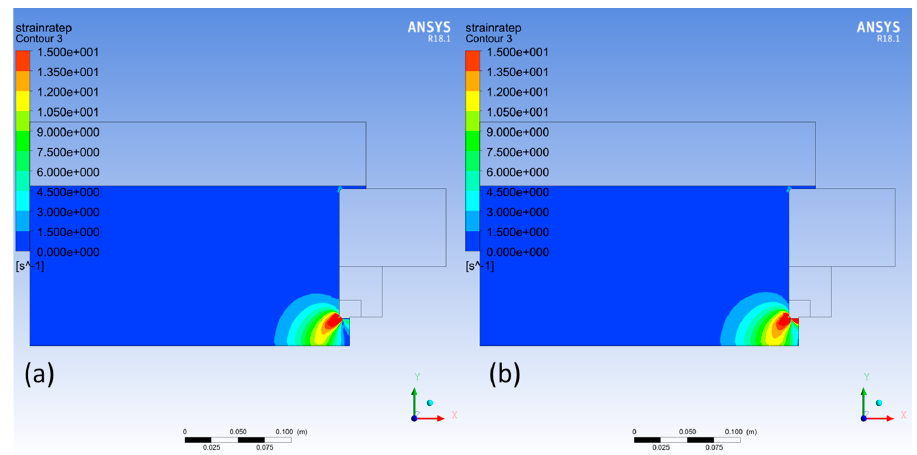
Figure 4. Contours of the equivalent strain rate (values larger than 15 s − 1 are clipped to the red color contour). ( a ) Solution with no friction f = 0 Ns/m 3 , S = 1.5 cm/s, f β = 0.5, T in = 715 °C, h = 1.7 W/(m 2 K). ( b ) Solution with friction f = 5 × 10 8 Ns/m 3 , S = 1.5 cm/s, f β = 0.5, T in = 715 °C, h = 1.7 W/(m 2 K).